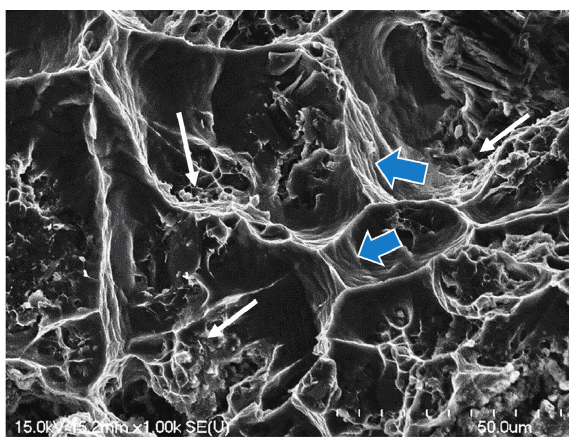
Figure 13: SEI of the fracture surface of composite C in the SHT condition